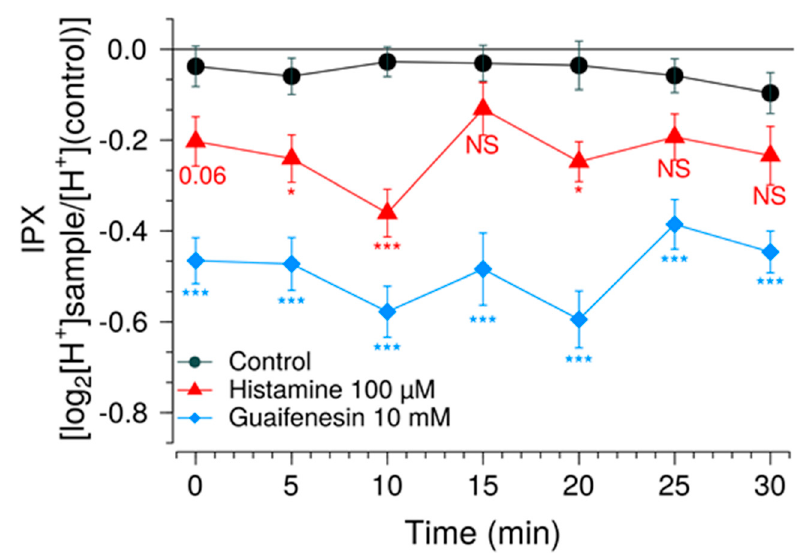
Figure 7. Effect of 10 mM guaifenesin on HGT-1 cells. Intracellular proton index (IPX) of HGT-1 cells exposed to 10 mM guaifenesin (blue diamonds). Recordings were performed at room temperature at intervals of 5 min. Histamine at a concentration of 100 µ M (red triangles) was used as positive control. Cells treated with vehicle solution served as negative control (black circles). Data presented as mean ± SEM. Statistical significance was evaluated using one-way ANOVA with Tukey’s range test for multiple comparisons. * denotes p < 0.05 and *** denotes p < 0.001 for the corresponding compound according to the assigned color when compared to the negative control. N of 4 BR, 8–16